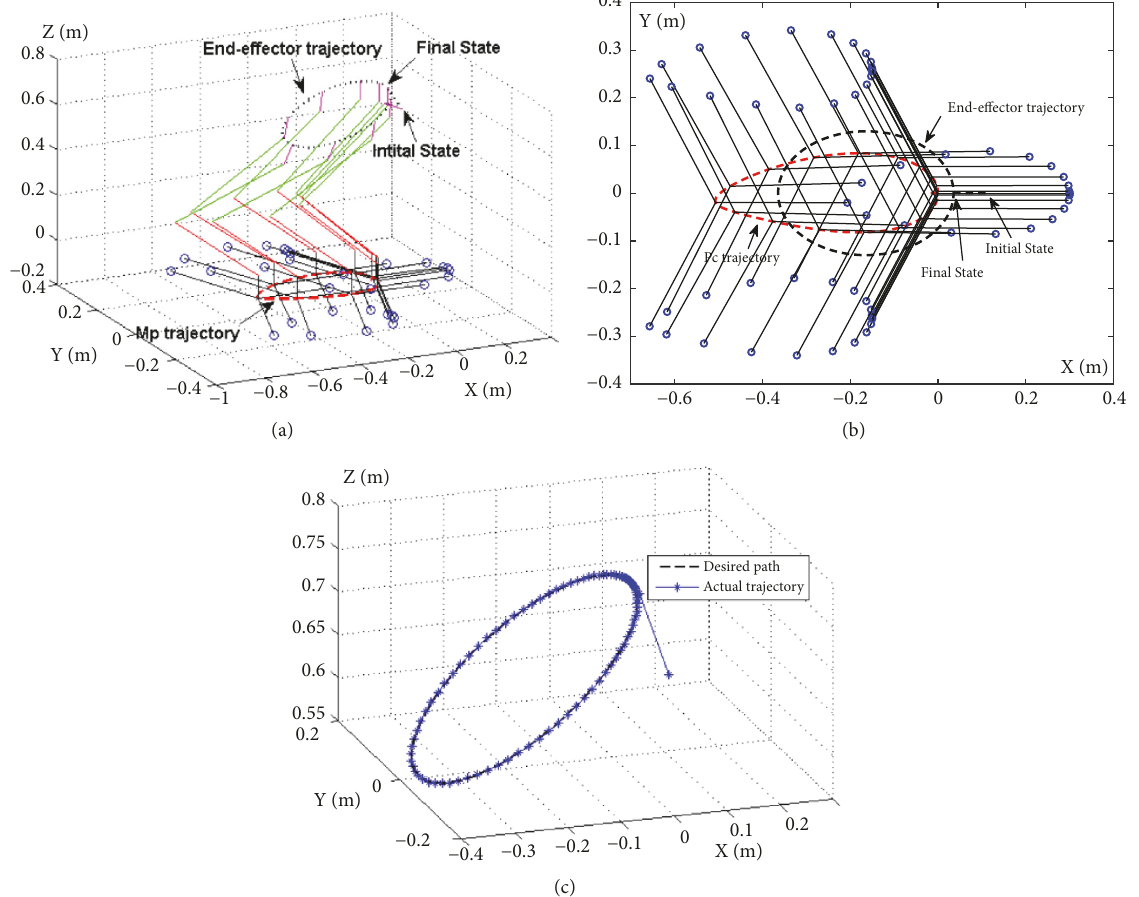
Figure 5: Simulation results about repeatable optimization of kinematic energy system with TTZNN solver when the end-effectoris required to complete a circular path. (a) Motion trajectories with the entire mobile manipulator. (b) Vertical view for entire mobile manipulator. (c) Profiles of the desired trajectory and actual path of the